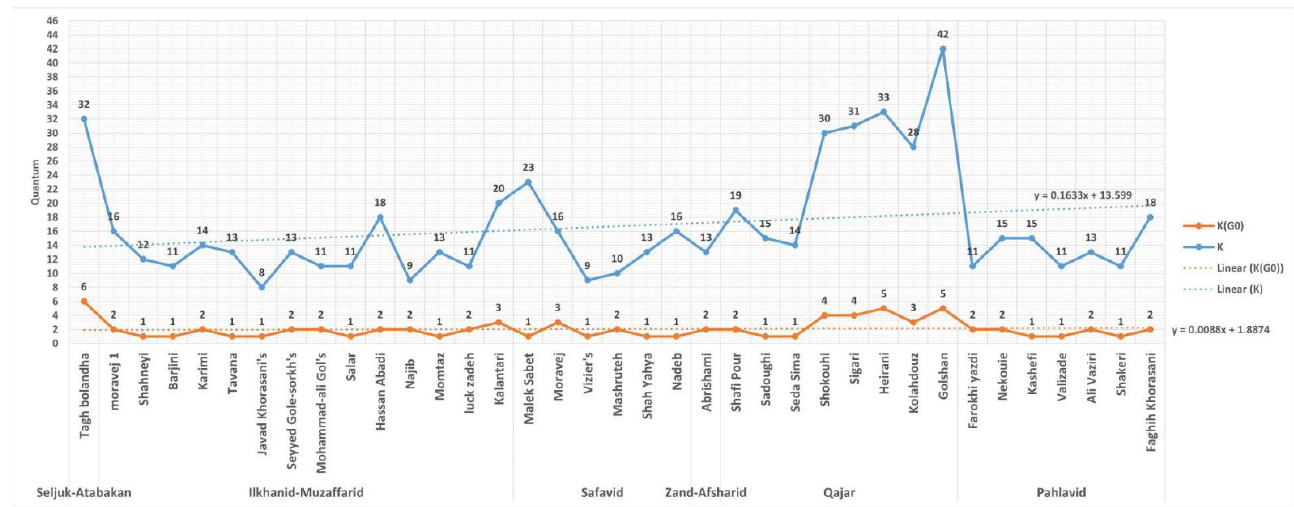
Figure 6. Number of enclosed rooms ( K ), number of courtyards ( K G0 ) and trendlines for the 37 houses, presented chronologically by era.